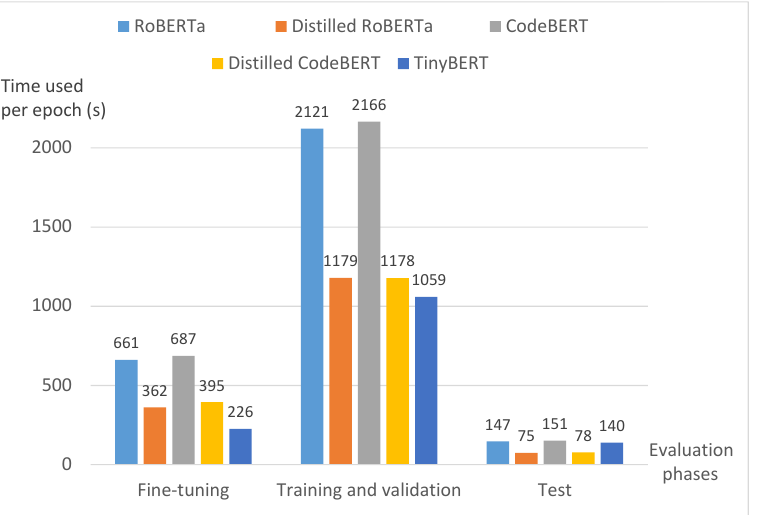
Figure 4. The comparison of the efficiency among five PCMs and distilled PCMs, measured by the time used in each epoch during the fine-tuning, training/validation, and test phases (the test phase is treated as one epoch). All models are evaluated with the training batch size being equal to 8 and validation batch size being